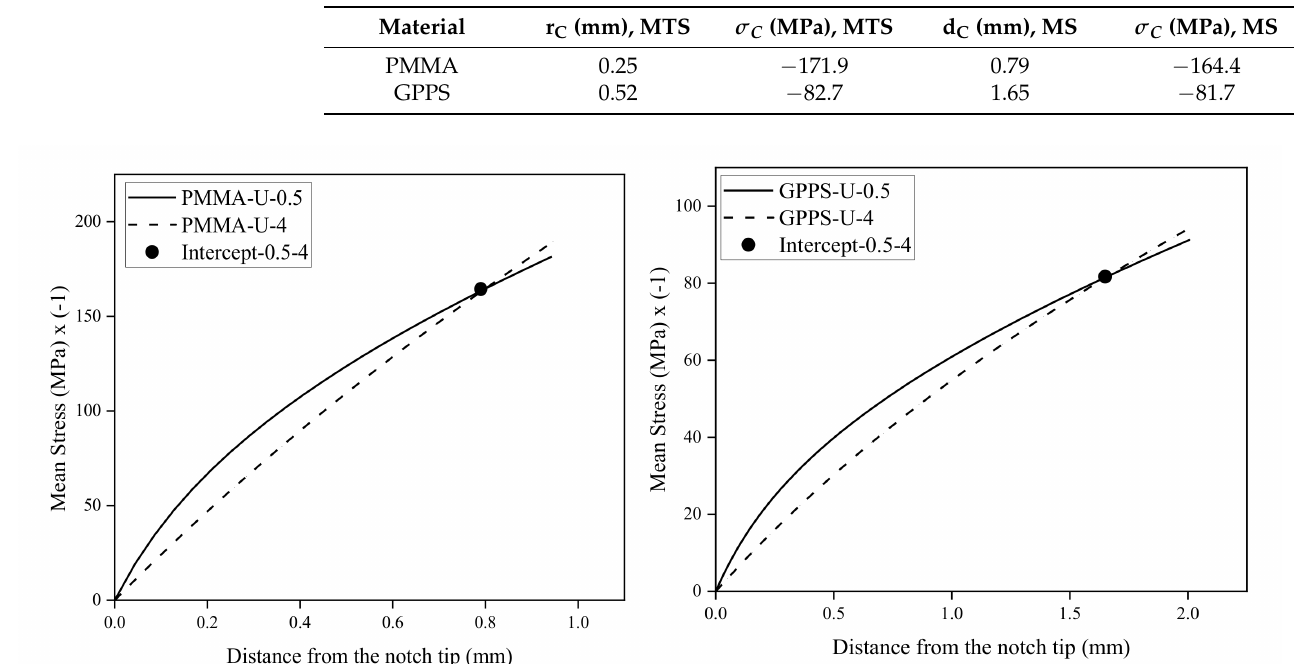
Figure 8. Compressive stress–distance curves at fracture for PMMA and GPPS materials. Table 3. Critical distance ( r C ) and critical stress ( σ C ) of PMMA and GPPS materials when following maximum tangential stress (MTS) and mean stress (MS) criteria.